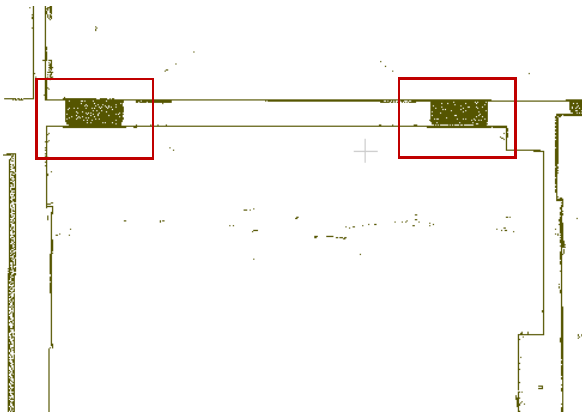
Figure 14 . Detail drawing of upper edge of